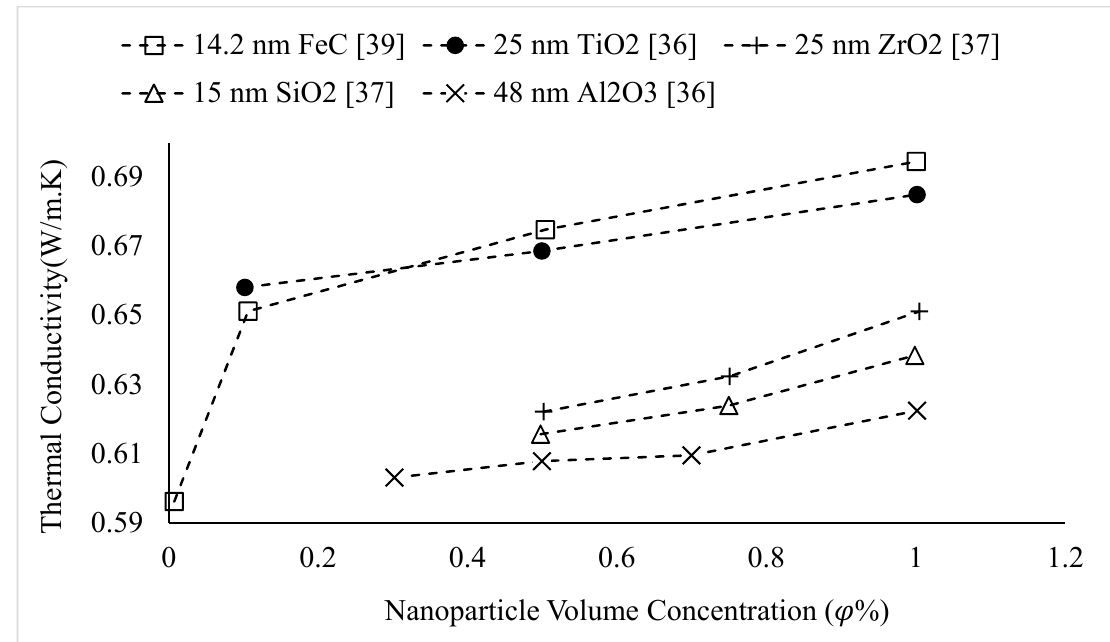
Figure 3. Variation of water-based nanofluid thermal conductivity as a function of nanoparticle volume concentration, 𝜑 , for different nanoparticles at room temperature.